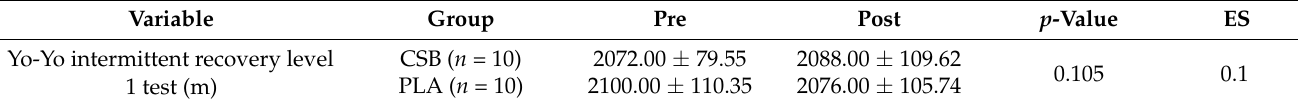
Table 5. Change of Yo-Yo intermittent recovery level 1 test following combined creatine and sodium bicarbonate supplementation. Variable Group Pre